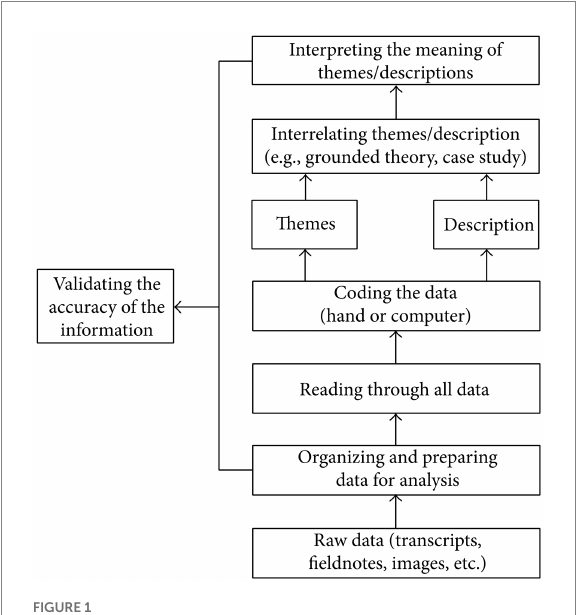
FIGURE 1 Creswell’s six-step model of qualitative